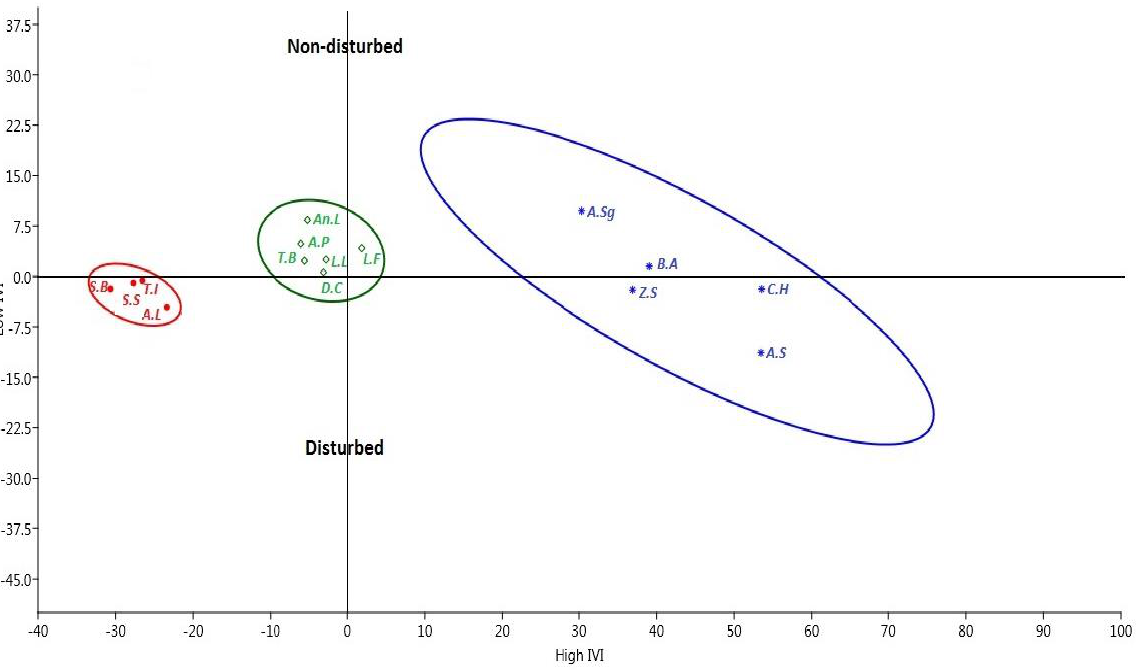
Figure 3. The projection of clustered groups of the common tree species at the disturbed and non-disturbed sites in the Dinder Biosphere Reserve, Sudan which was performed in the principal component analysis (PCA) based on the importance value index (IVI) values. Blue colored species are those with highest IVI, i.e., A.S = Acacia seyal var seyal , C.H = Combretum hartmannianum , Z.S = Ziziphus spina-christi , B.A = Balanites aegyptiaca , A.Sg = Acacia senegal . Green colored have intermediate IVI, i.e., An.L = Anogeissus leiocarpus , A.P = Acacia polyacantha Will, L.F = Lannea fruticosa , D.C = Dichrostachys cinerea , T.B = Terminalia brownii , while the red colored group has a low IVI, i.e., T.I = Tamarindus indica , S.B = Sclerocarya birrea (A. Rich) Hochst , A.L = Acacia seyal (Del.) var fistula (Schweinf) Oliv , and S.S = Sterculia setigera .